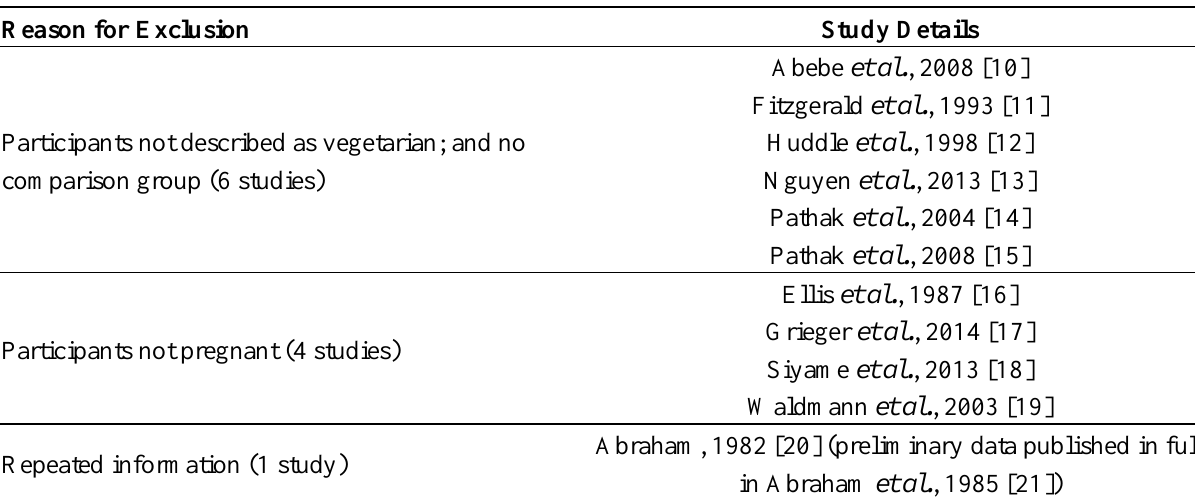
Table 1. Reasons for study